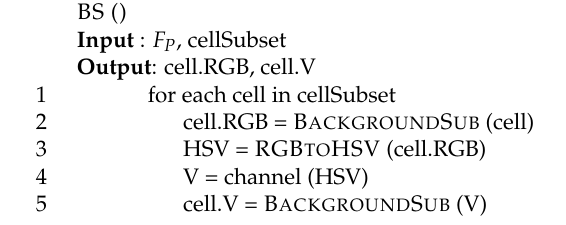
Figure 3. Background subtraction: function